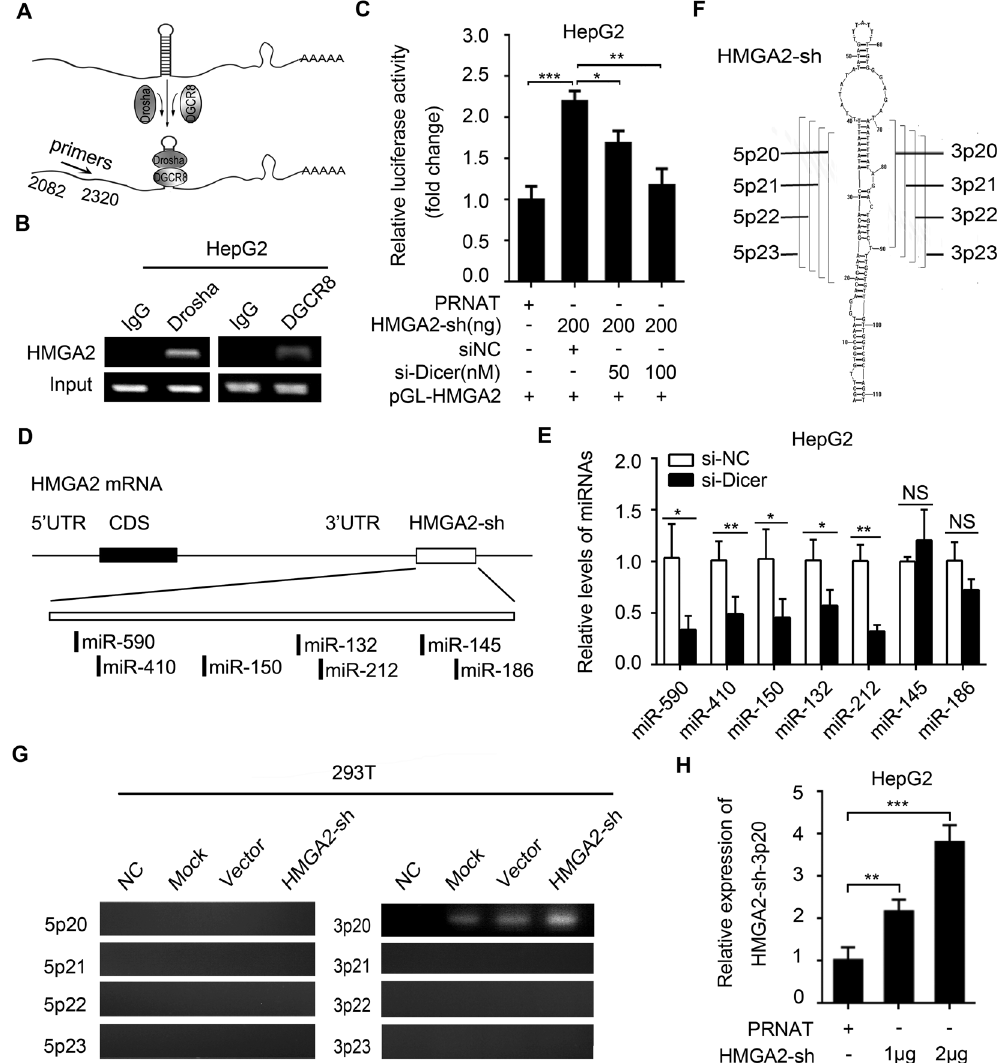
Figure 2. A fragment, HMGA2-sh-3p20, is cleaved from HMGA2-sh by Drosha/DGCR8 complex and Dicer. ( A ) The diagram of the interaction between Drosha/DGCR8 and the hairpin structure. ( B ) Drosha (or DGCR8) RIP-PCR of HMGA2 mRNA in HepG2 cells. ( C ) Effect of si-Dicer on luciferase activities of HMGA2-sh- mediated pGL3-HMGA2 was measured by luciferase reporter gene assays in HepG2 cells. ( D ) The diagram shows the predicted miRNAs targeting pGL-HMGA2. ( E ) Effect of si-Dicer on the expression of miR-590, miR-410, miR-150, miR-132/212, miR-145 and miR-186 was examined by qRT-PCR in HepG2 cells. ( F ) The diagram shows the designed primers for fragments derived from HMGA2-sh. ( G ) The fragments were screened by RT-PCR using designed primers in HMGA2-sh-overexpressed 293T cells. NC, purified water; Mock, without plasmid DNA; Vector presents empty plasmid DNA. The full bands images are given as Supplementary Fig. S6. ( H ) The identified fragment, HMGA2-sh-20, was validated by qRT-PCR analysis in HepG2 cells transiently transfected with HMGA2-sh. Every experiment was repeated three times. Error bars represent s.d. (n = 3), ** p < 0.01; *** p < 0.001, Student’s t